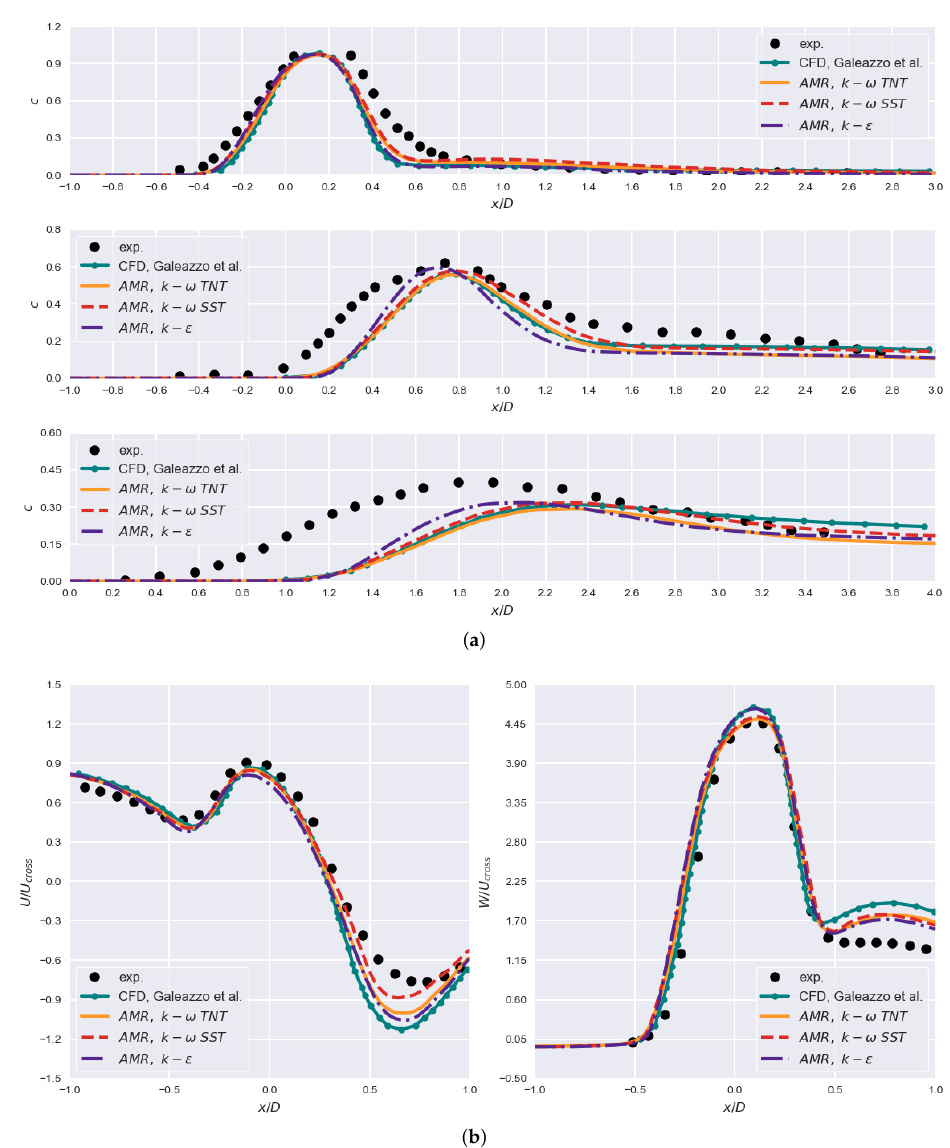
Figure 7. Results obtained for the AMR approach for cases where mesh size is similar to the fine grid: ( a ) scalar concentration at z / D = 1.5, z / D = 3, z / D = 4.5 (top to bottom) where y / D = 0; ( b ) profiles of mean velocity components for y / D = 0 and z / D = 1. Figure 8 further underscores turbulence-model-associated discrepancies for velocity component U / U cross . It is interesting to note that at z / D = 1.5 and z / D = 3, the k −